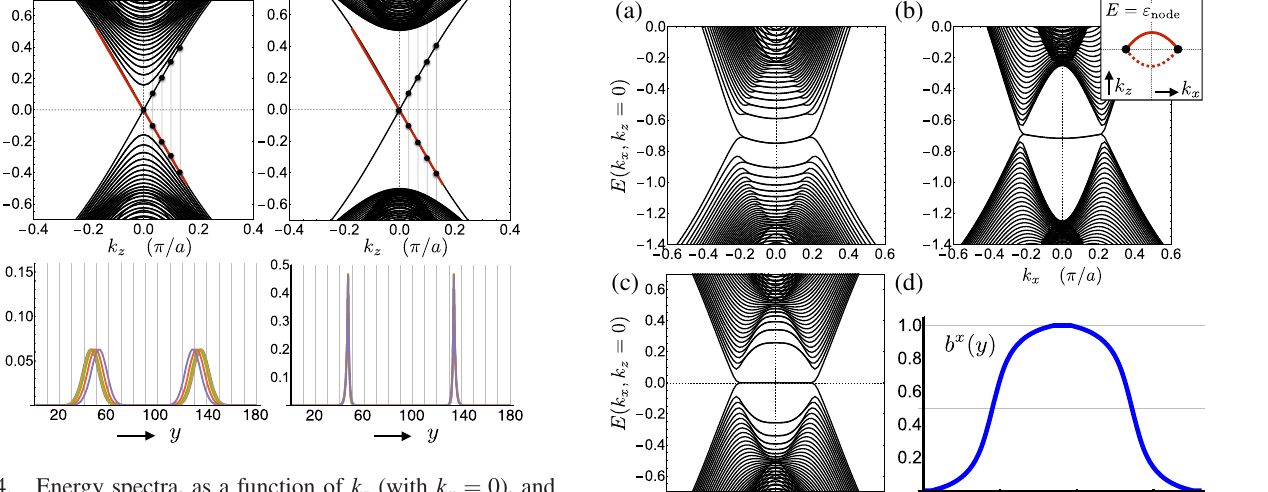
0 ), and FIG. 4. Energy spectra, as a function of k (with k z x ¼ wave-function support obtained from Eq. (28) in the presence of a bulk axial magnetic field B z 5 (left) and for an interface boundary between an insulator and a Weyl semimetal (right). The spatial FIG. 5. Effect of the Fermi arc curvature and deviations from profile of b x ð y Þ corresponding to the left and right panels here are constant axial magnetic fields. (a,b) Plot of the energy spectra P given in the leftmost and rightmost bottom panels of Fig. 1, a σ 0 s 0 added to Eq. (28) and δ t set to δ t ¼ 0 . 25 . with − δ t cos k i i respectively. On the left, the low-energy branch of the spectrum The b x ð y Þ profiles corresponding to (a) and (b) are given in the has the structure of pseudo-Landau levels. The linearly dispersing leftmost and rightmost bottom panels of Fig. 1, respectively, with chiral (black) and antichiral (red) modes are the n ¼ 0 pseudo- m ¼ 0 . 5 . The effect of finite δ t is to give k dispersion to the x Landau levels. The wave-function support of n ¼ 0 modes is pseudo-Landau levels (a) and the Fermi arc states (b). The inset of − k shown for states with k values, indicated by solid black dots. On (b) shows the Fermi arc states in the k plane at the node z x z the right, the linearly dispersing modes correspond to the Fermi energy ε . (c) Energy spectrum obtained from Eq. (28) with node arc surface states and are sharply localized at the boundary b x ð y Þ as shown in (d), with m ¼ 0 . 5 . Profile (d) leads to a interfaces l 1 and l 2 (see Fig. 1). The same systems sizes as in nonuniform B 5 ¼ B 5 ð y Þ ≃ ∇ × b , which is reflected in (c), Figs. 1 and 2 are used. because where the n ≥ 1 pseudo-Landau levels disperse in k x of position-momentum